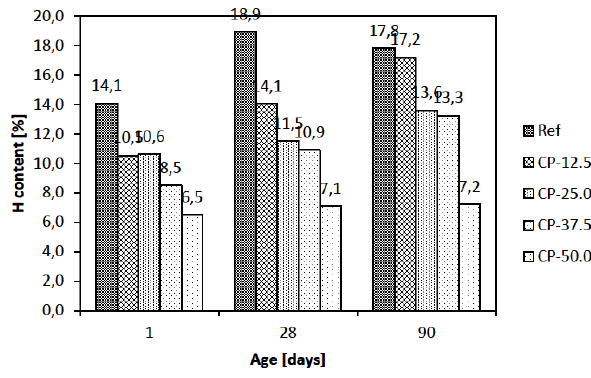
Figure 6: Development of Ca(OH) 2 in pastes with blast furnace slag addition in time.